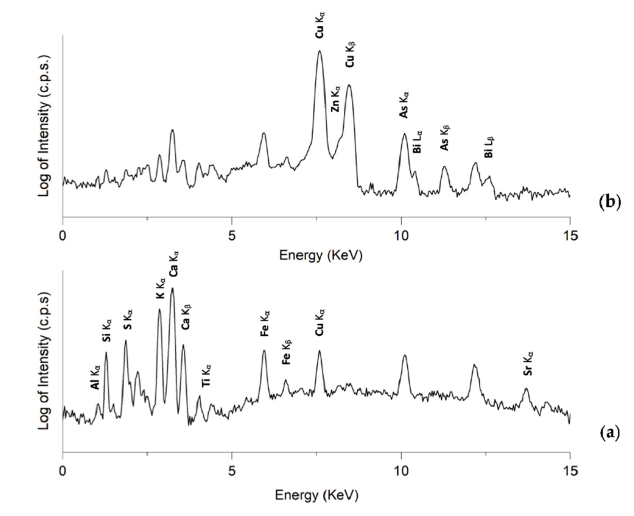
Figure 2. XRF spectra of ultramarine ( a ) in point 3 of 8r and azurite ( b ) in point 2 of 18r.